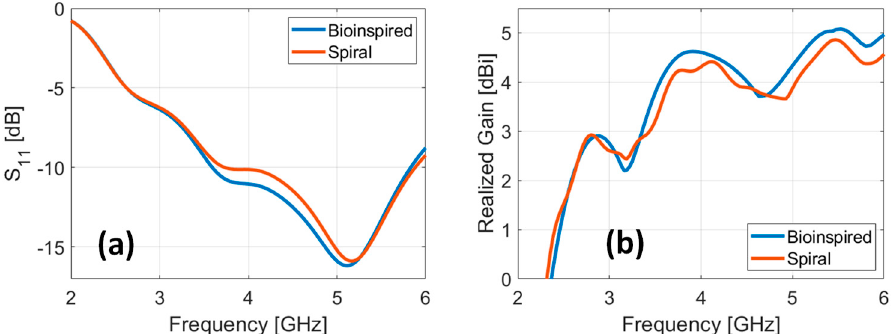
Figure A2. ( a ) Scattering parameter S 11 and ( b ) gain of the bio-inspired SsDRA (blue curve) and LsDRA (red curve).